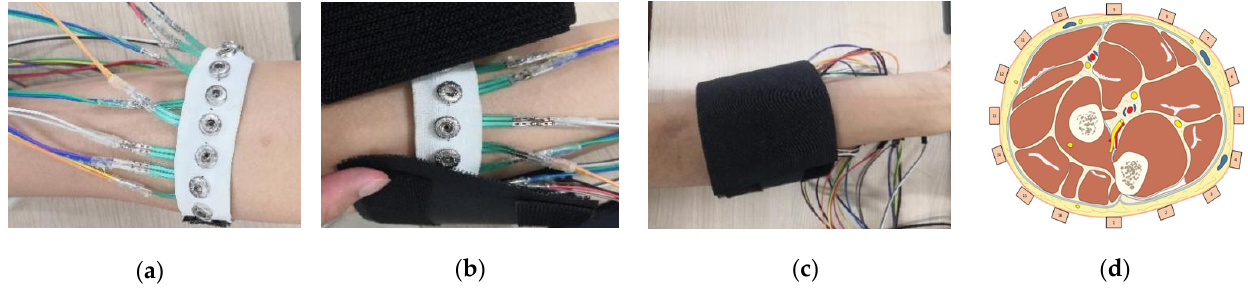
Figure 5. The wearing of FMG band on the forearm: ( a ) wearing the sensing armband; ( b ) covering the sensing armband by a non-stretchable fabric; ( c ) covered sensing armband; and ( d ) the positioning order of 16 FSR sensors.